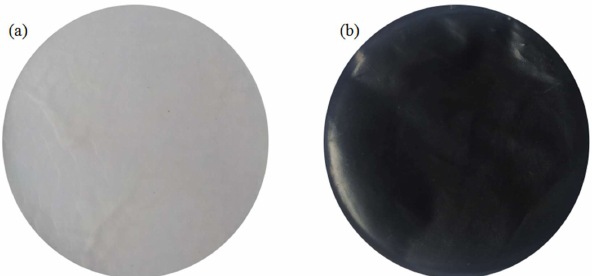
Figure 2. Digital photos of ( a ) pure Pebax membrane, ( b ) GO/SWCNTs/Pebax1657 membrane.